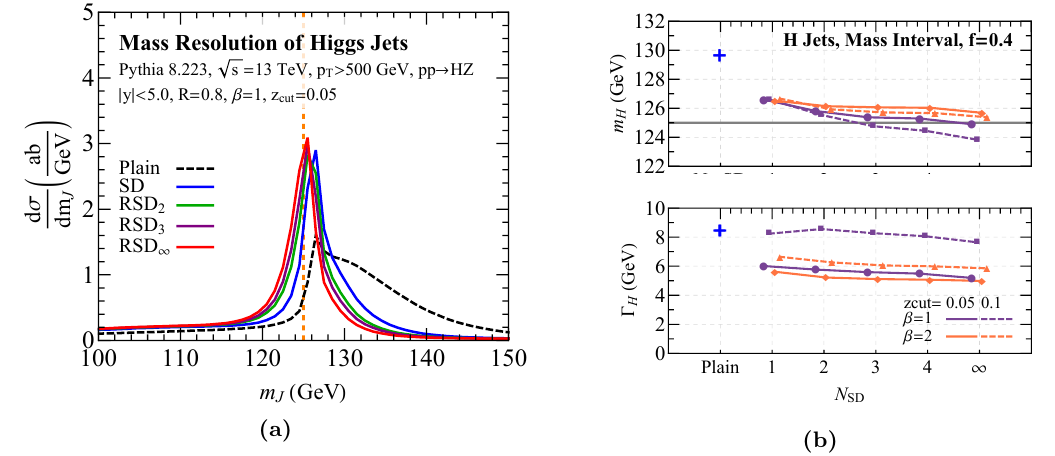
Figure 8. Same as (cid:12)gure 6 but for the Higgs jet